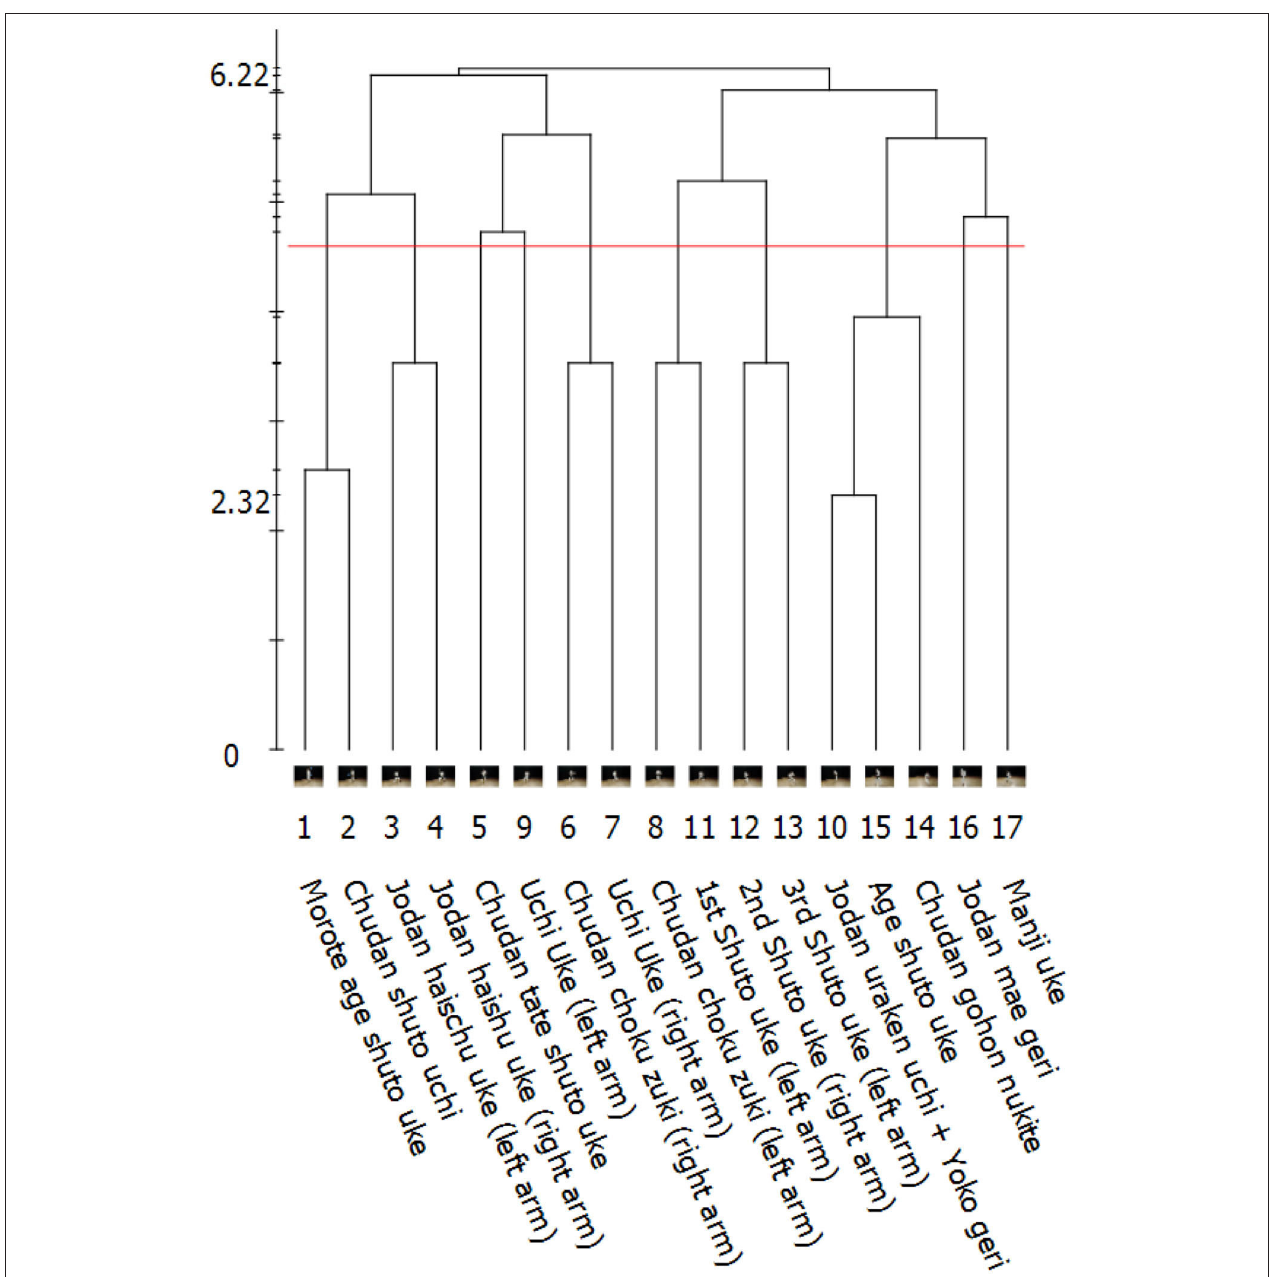
FIGURE 2 | Visualization of a 5th kyu (blue belt) karate practitioner’s individual mental representation structure related to the Kanku-dai movement sequence by an SDA-M dendrogram. Numbers below the dendrogram indicate designated positions of each action within the